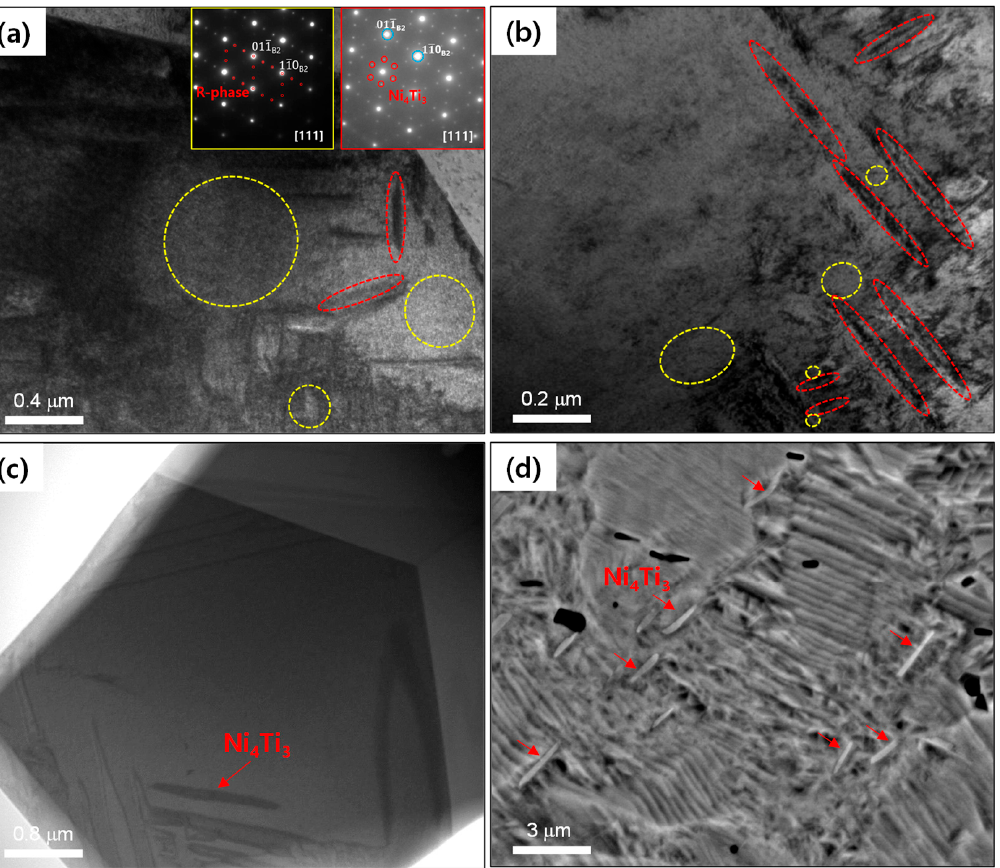
Figure 9. The TEM micrographs for the aged HRDSR sample (after annealing for 5 min): ( a ) near grain boundaries and ( b ) grain interior. The ( c ) TEM and ( d ) SEM micrographs for the aged HRDSR sample (after annealing for 120 min). The regions marked by yellow and red circles represent the regions where B2+ R phases and B2+Ni 4 Ti 3 phases are identified to exist, respectively.